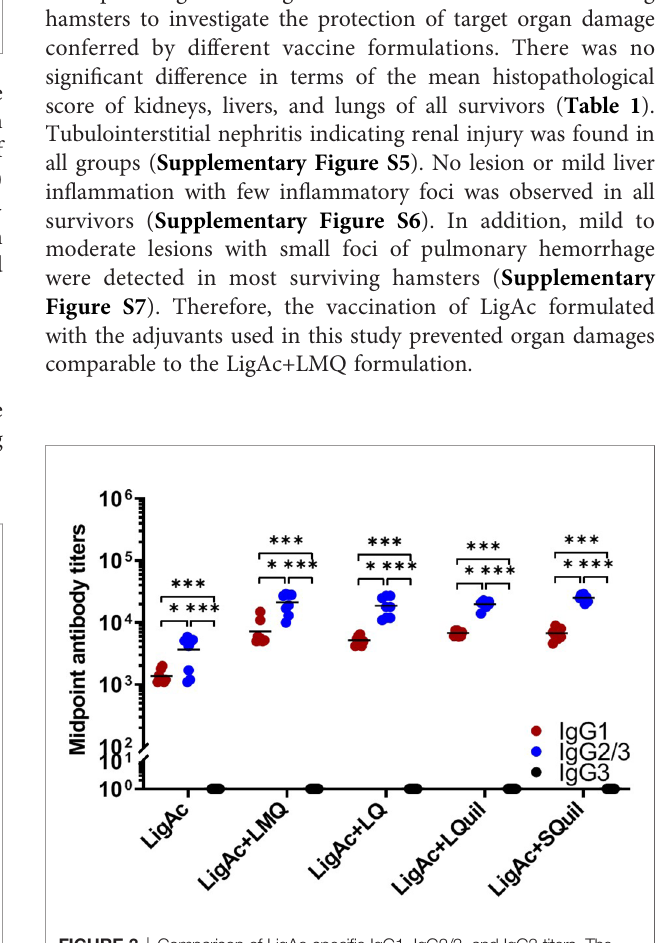
FIGURE 3 | Comparison of LigAc-speci fi c IgG1, IgG2/3, and IgG3 titers. The antibody titers in the vaccinated hamsters at o1 week after the third immunization were measured by ELISA. Mann – Whitney U test was used to compare IgG isotype titers between groups; * represents p < 0.05. and *** represents p <